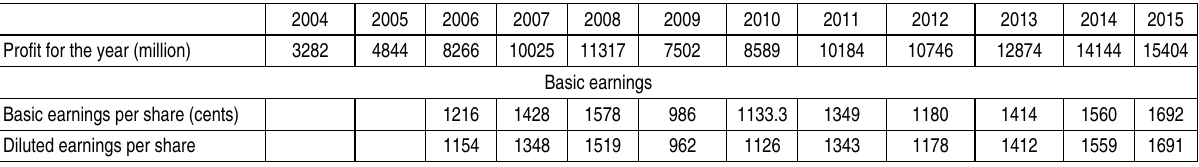
Table 1. Summary of financial results for ABSA/Barclays